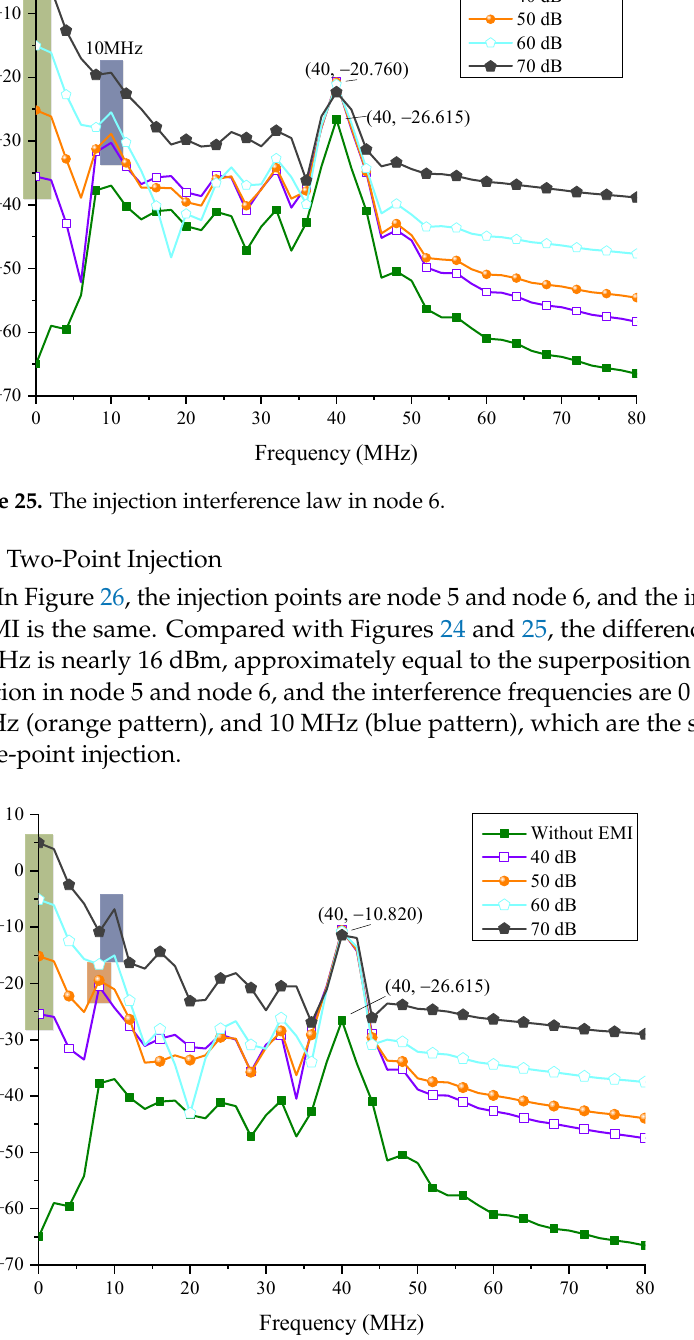
Figure 24. The injection interference law in node 5.